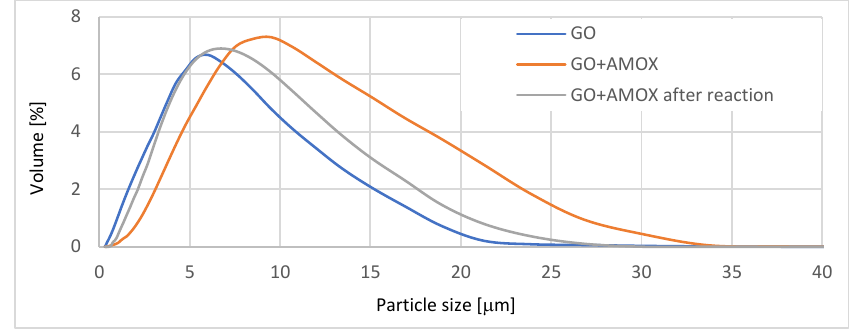
Figure 4. GO flakes size distribution.